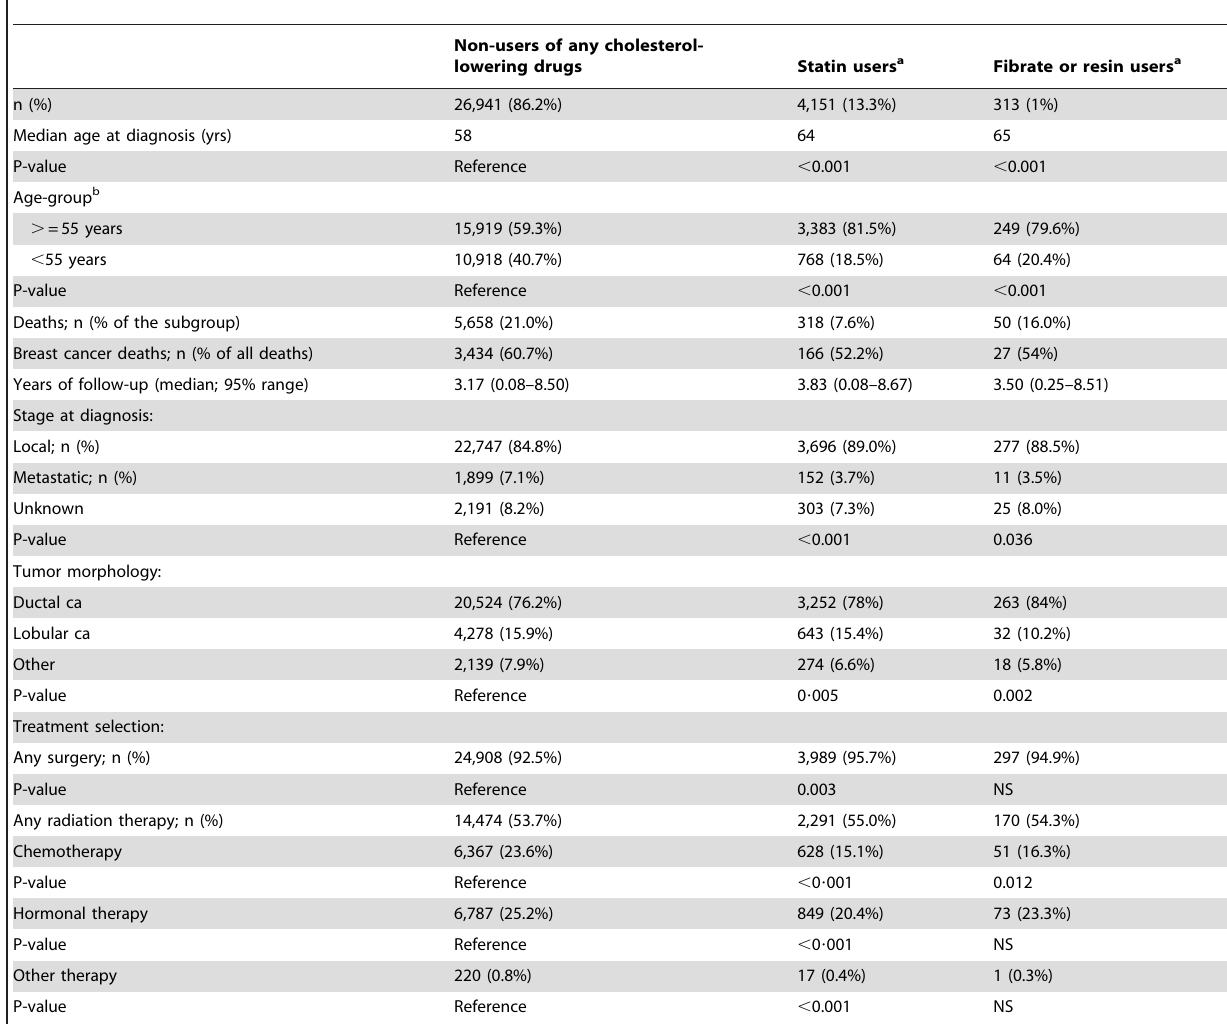
Table 1. Baseline population characteristics of all breast cancer cases diagnosed in Finland during